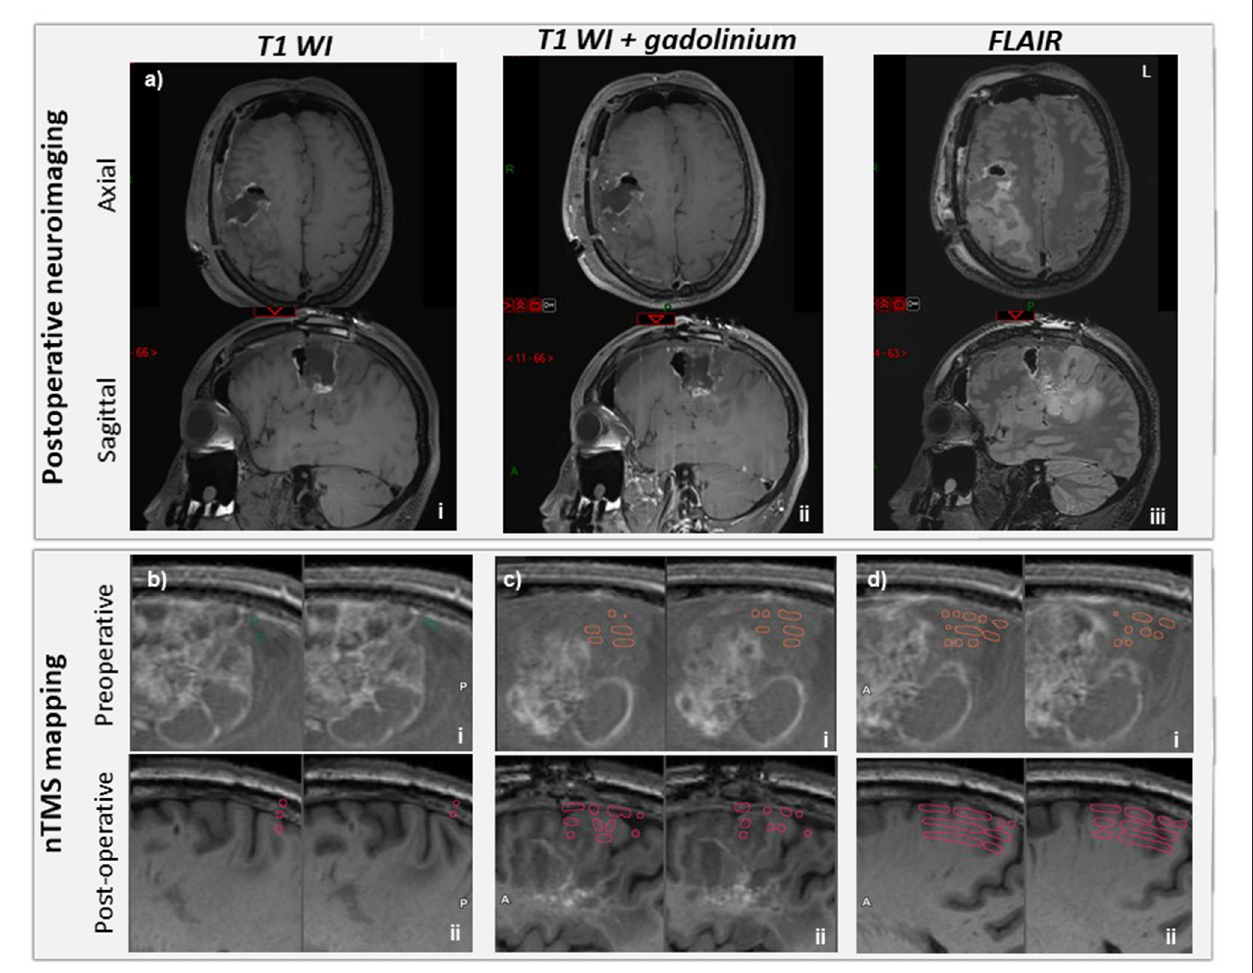
FIGURE 4 | Post-operative neuroimaging status of the patient. (a) Day 1 postoperative MRI: axial (upper panel) and sagittal (lower panel) slices, T1WI (i), T1WI after gadolinium contrast injection (ii); FLAIR (iii). No residue with contrast enhancement was found. (b) Navigated transcranial magnetic stimulation (nTMS) mapping of left first dorsal interosseous (FDI) before (i, ROI in green) and 3 weeks after tumor resection (ii, ROI in pink). FDI nTMS map was shifted posteriorly 3 weeks after tumor resection. (c) nTMS map of left tibialis anterior (TA) before (i, orange) and 3 weeks after tumor resection (ii, pink) being larger with a posterior shift. (d) nTMS map of left deltoid before (i, orange) and 3 weeks after tumor resection (ii, pink) being larger with a posterior